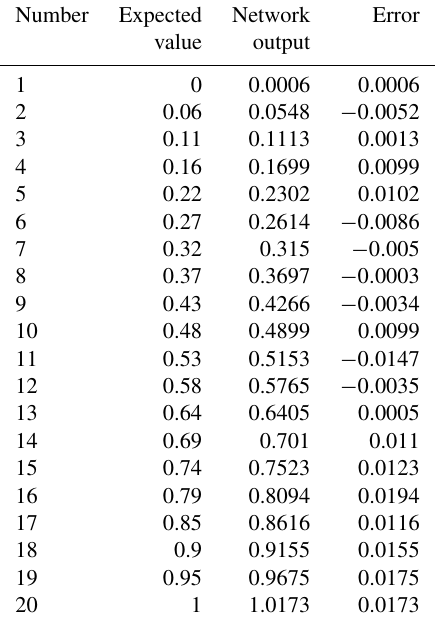
Table C1. Test error of LM-BP neural network.